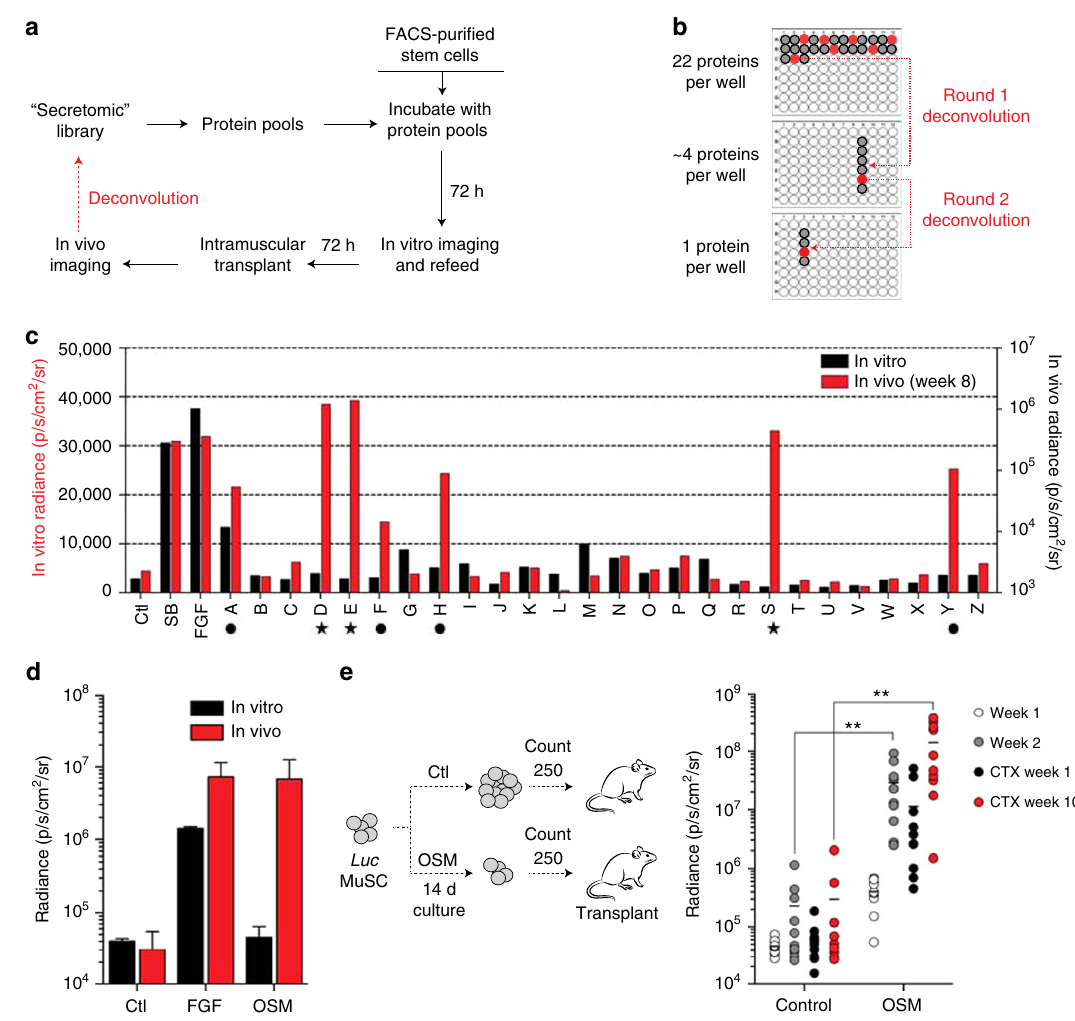
Fig. 1 Identi fi cation of Oncostatin M as a potent inducer of muscle stem cell engraftment. a Schematic of combined in vitro/in vivo bioluminescence imaging (BLI) screening strategy. b Schematic of deconvolution for positive protein pools. Pools of 22 proteins scoring for engraftment in the initial round of screening were iteratively deconvolved into pools of 4 proteins, and then individual proteins. c Results of multiplexed in vitro/in vivo protein screening. Black, results of in vitro BLI; red, results of in vivo BLI. Ctl: control buffer; SB: SB202190; FGF: recombinant human basic fi broblast growth factor. Symbols below the axis mark pools containing OSM (star), and all other hits (circle; includes FGF, TNFR, and incompletely deconvolved pools). d Representative BLI results following treatment of 800 FACS-sorted MuSC with either FGF or Oncostatin M (OSM; 100 ng/mL) for 6 days in vitro, followed by intramuscular transplantation (3 8-12 week old animals each) and in vivo BLI measurement 6 days (open circles) or 2 weeks (shaded circles) after transplant. e Schematic (left) demonstrating transplantation of 250 counted progeny of CD11b − Sca1 − CD31 − CD45 − CD34 + αα 7 integrin + stem cells following long-term 2 week culture with OSM control conditions (FGF). Serial BLI following transplantation of counted cells (right). Each point indicates an individual hindlimb that received a 250 cell transplant, n = 10 per condition. BLI is shown for weeks 1 (white) and 2 (light gray) pre-CTX, and weeks 1 (dark gray) and 10 (red) post- CTX. Double asterisks indicate p < 0.01 in comparison with control condition at the same